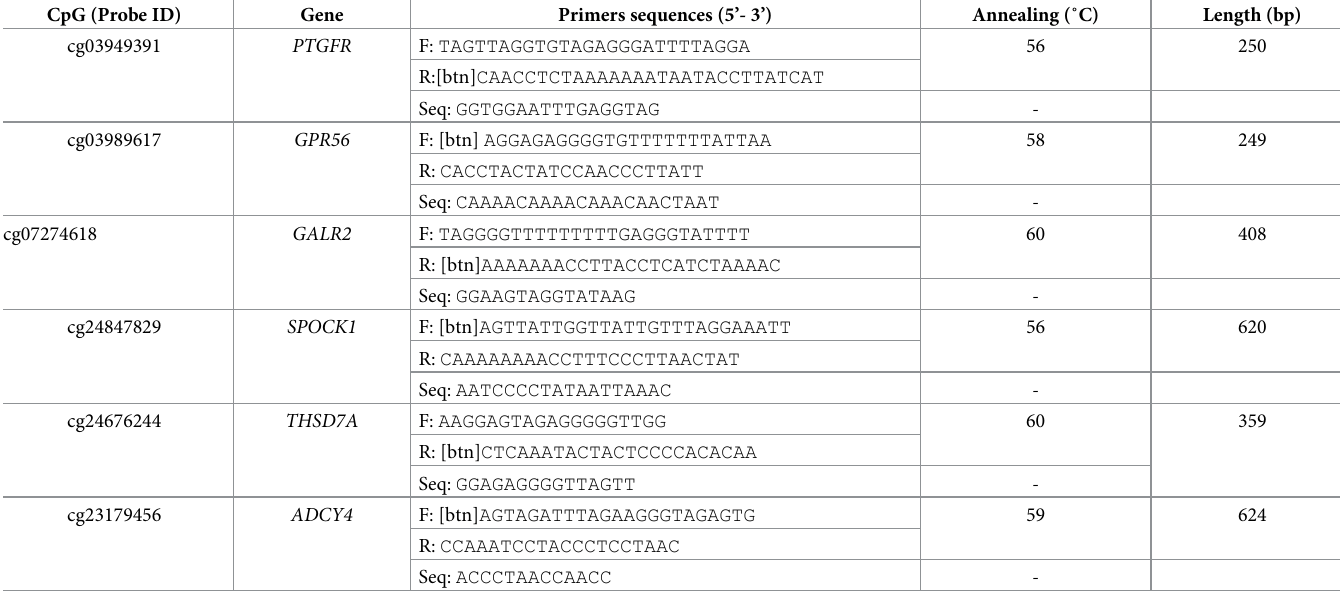
Table 1. Primers sequences used for pyrosequencing analysis.